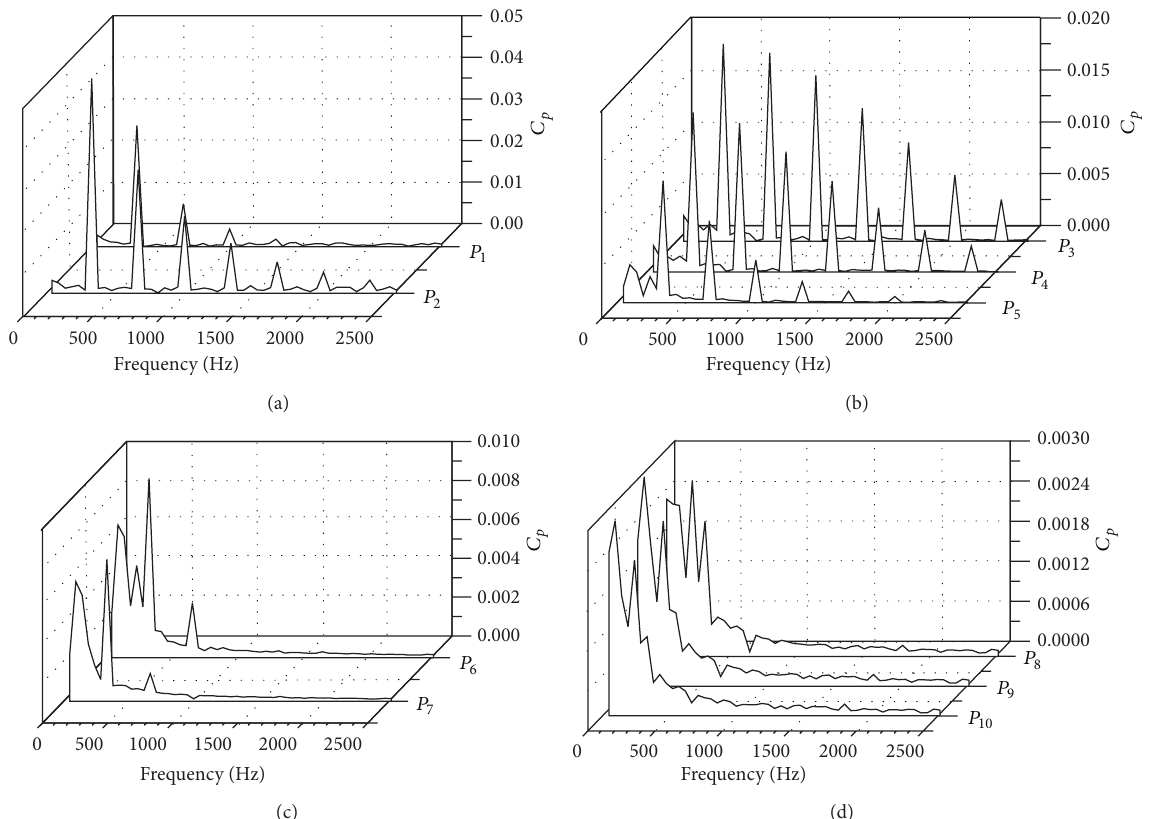
Figure 11: Frequency spectra at different locations: (a) impeller leading edge, (b) impeller trailing edge, (c) RGV leading edge, and (d) within